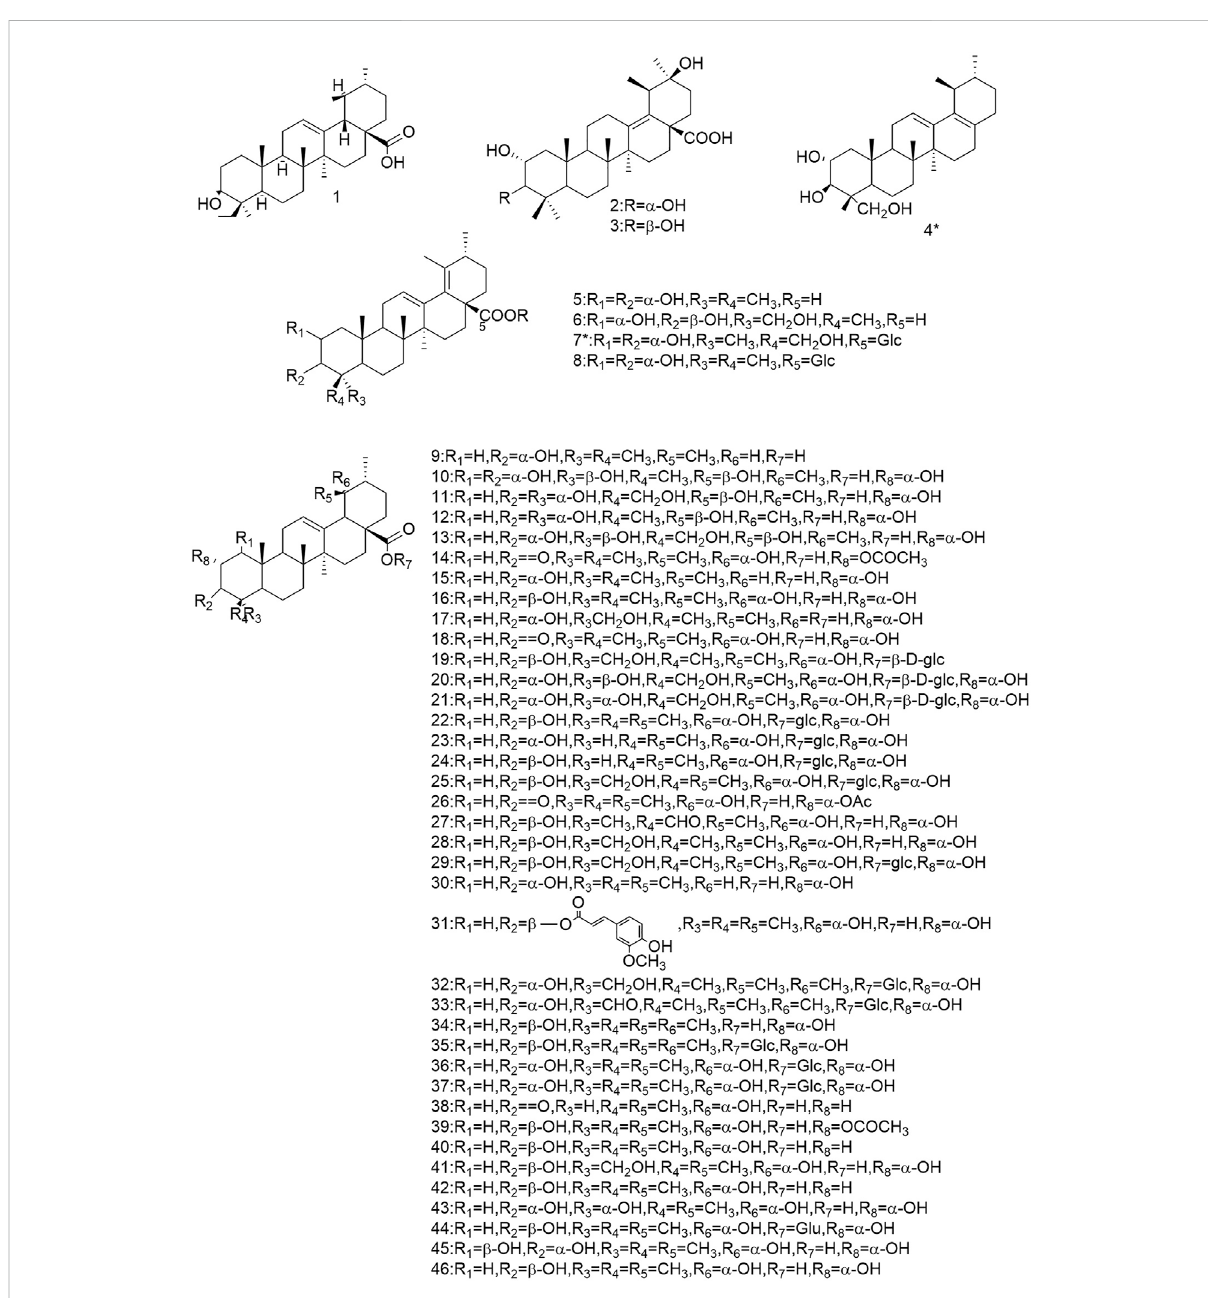
FIGURE 1 Diagrammatic representation of the structural formulas of triterpenoids of compounds found in R. laevigata